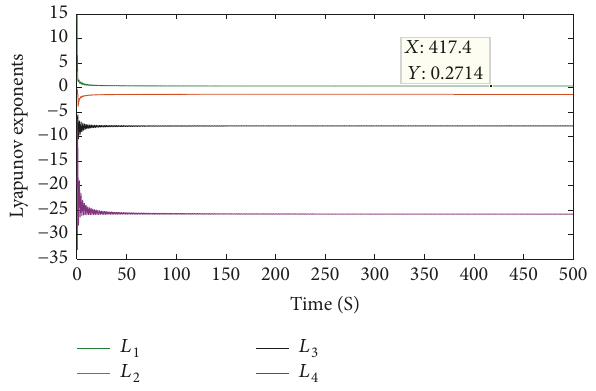
Figure 2: Lyapunov exponents of the smart grid system (1).